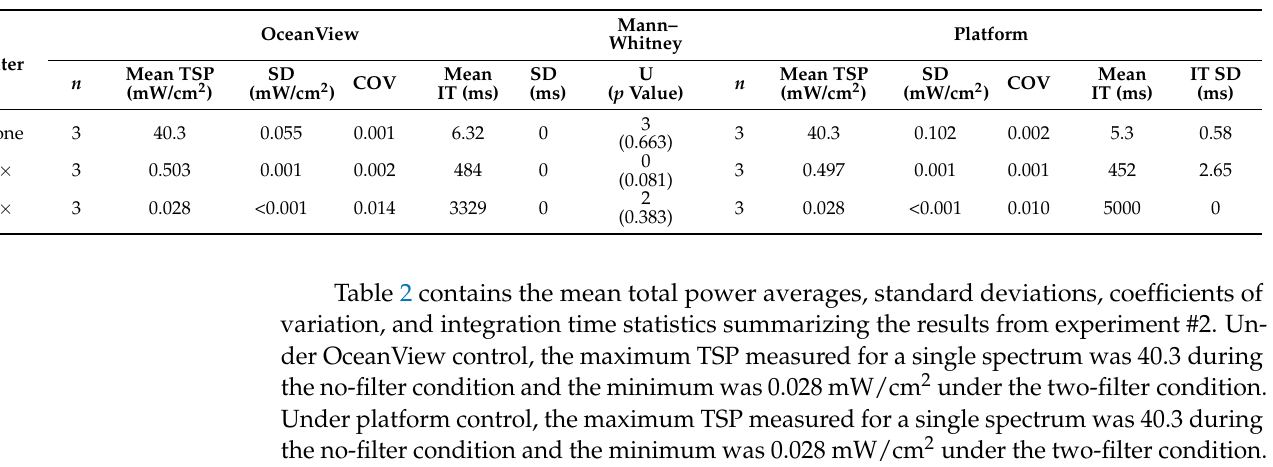
Figure 5. The slope of linear regressions for each pixel computed using three data points corre- sponding to platform- vs. OceanView-controlled measurement during each of the three filter con- ditions. The chart shows the regression slopes diverge from a value of unity at the wave- lengths below approximately 370 nm, with the greatest divergence from unity occurring at 353 nm and having a value of 1.14.